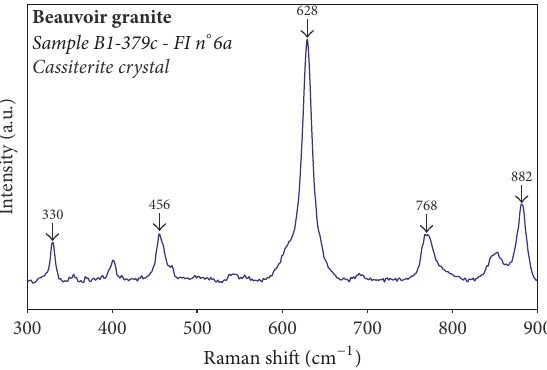
Figure 8: Raman spectrum of a cassiterite crystal contained in a primary L1-type fluid inclusion within a magmatic quartz crystal of the Beauvoir granite (sample B1-379c, FI n ∘ 6a). The Raman shift values indicated on the spectrum correspond to the Raman peaks of cassiterite. The other peaks are those of the